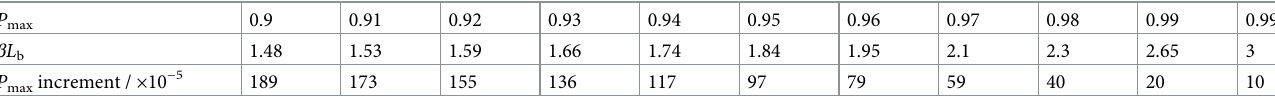
Table 3. A comparison between the peak axial force and β L b eigenvalues.